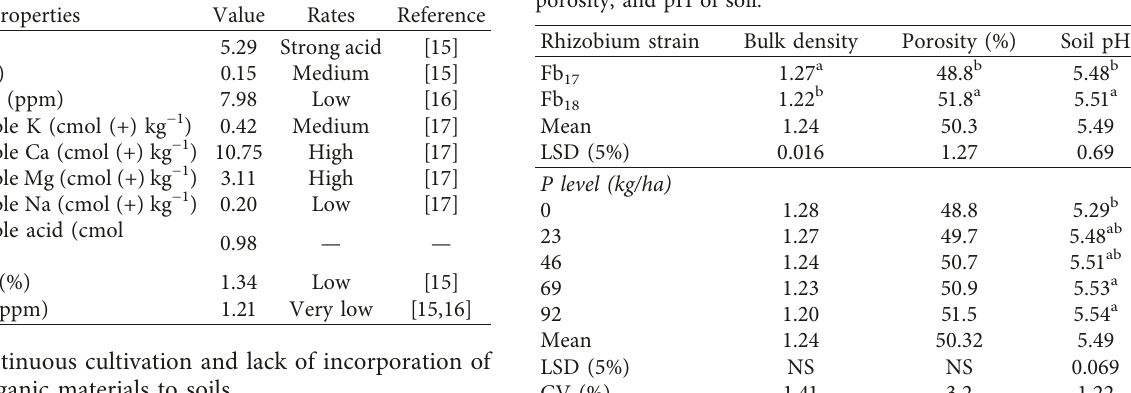
Table 3: Main effect of strain and P fertilizer on bulk density, total porosity, and pH of